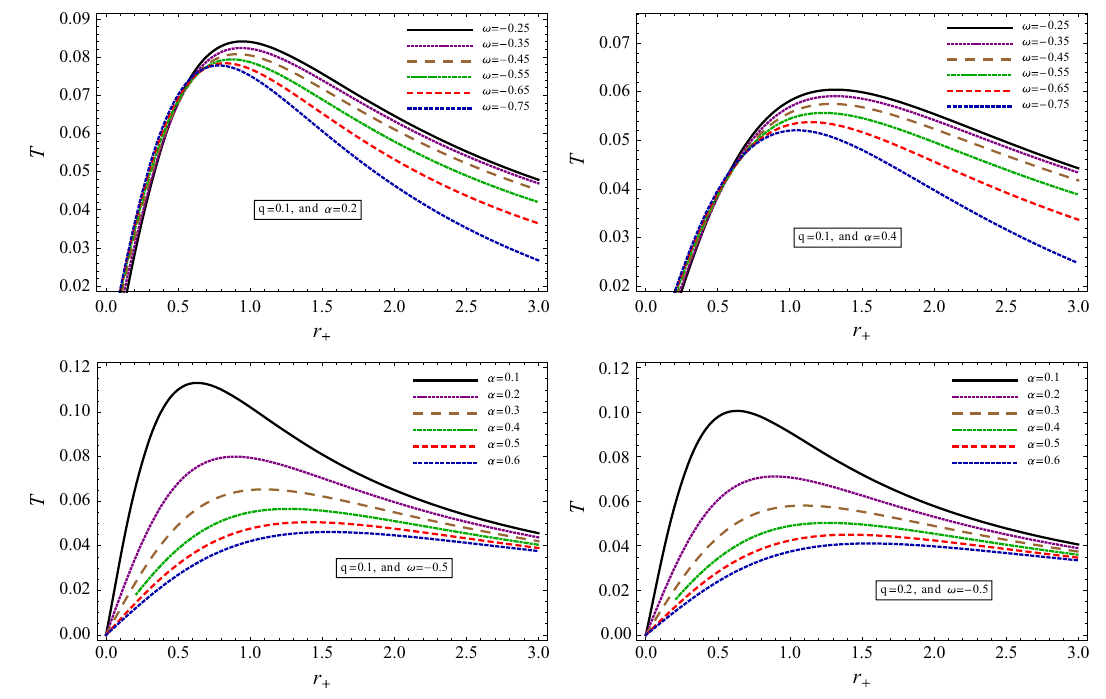
Fig. 3 The Hawking temperature ( T EGB + ) vs. horizon radius r + for different values of α ω with fixed q = 0 . 1 for the 5D